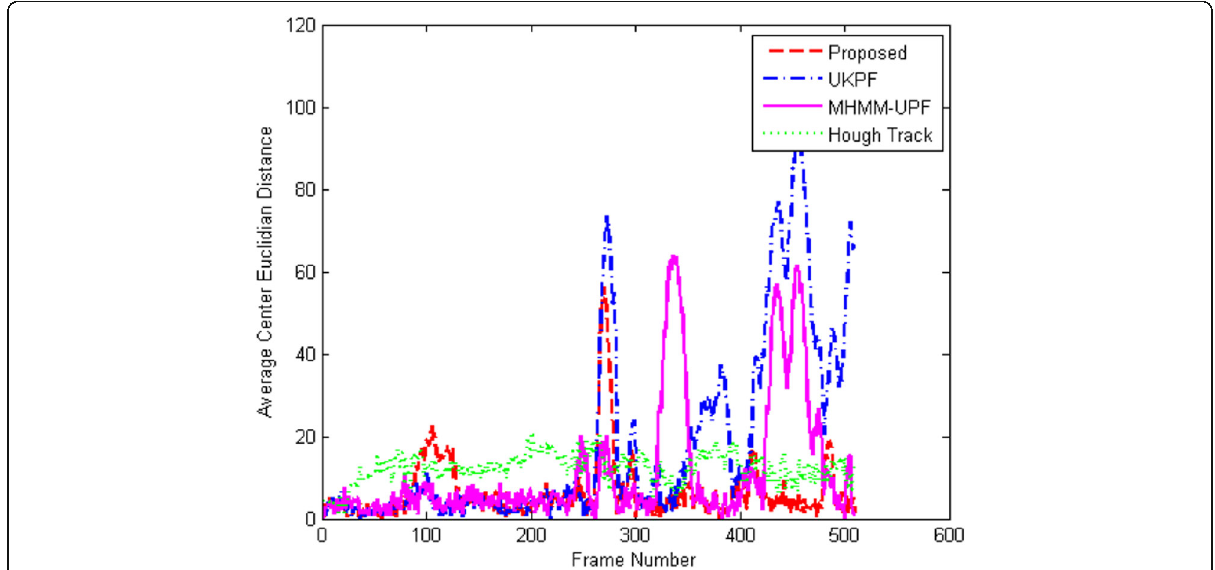
Fig. 12. Tracking result of Euclidian distance of “ Hand1